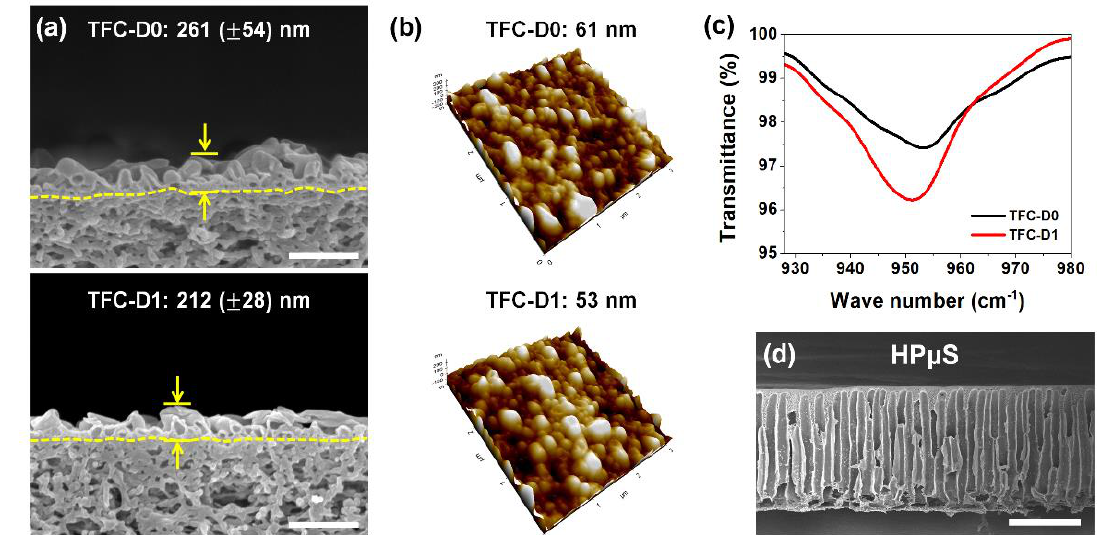
Figure 1. ( a ) Cross-sectional SEM images (Scale bar: 500 nm) and ( b ) AFM images of TFC-D0 (top) and TFC-D1 (bottom) membranes with the average thickness and roughness values of the active layers, respectively. ( c ) FTIR spectra of TFC-D0 and TFC-D1 membranes observed at 950 cm − 1 . ( d ) Cross- sectional SEM image of the HPμS membrane ( Scale bar: 50 μm ).